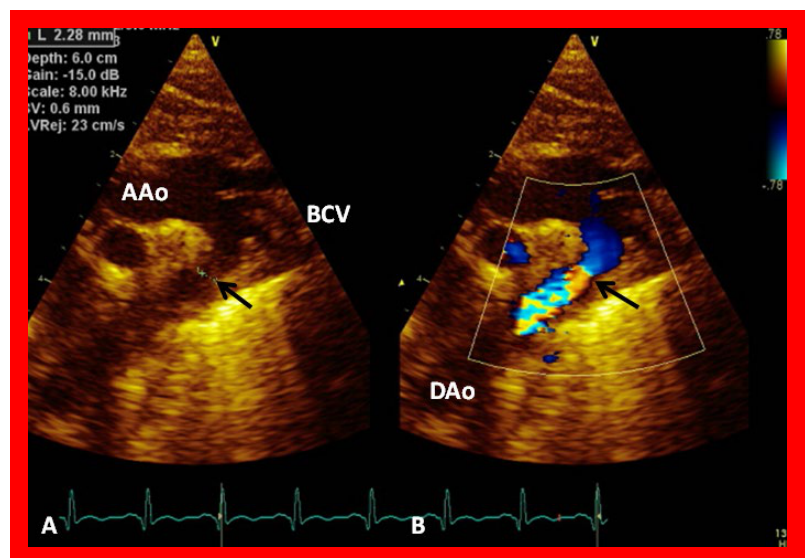
Figure 31. ( A ) Suprasternal notch view of a normal aortic arch (Arch) demonstrating the ascending aorta (AAo), aortic arch (Arch) and descending aorta (DAo). Note the origin of the right innominate (RInn), left common carotid (LCC) and left subclavian (LSA) arteries, arising from the aortic arch. ( B ) The same view with color Doppler imaging, showing red flow in the AAo and blue flow in the DAo. Reproduced from Reference [53].